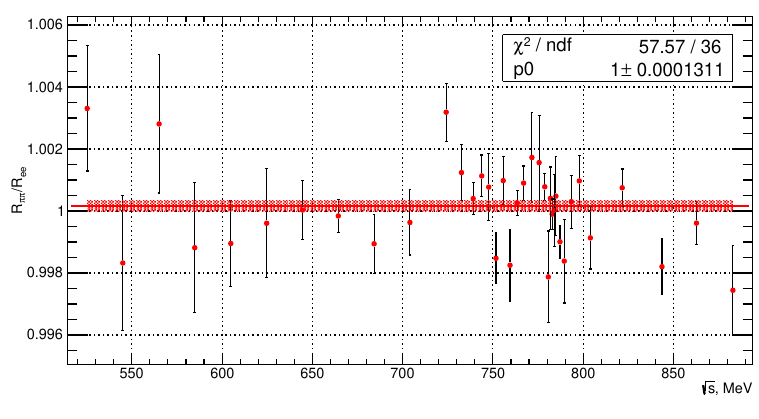
p s . Line depicts an average